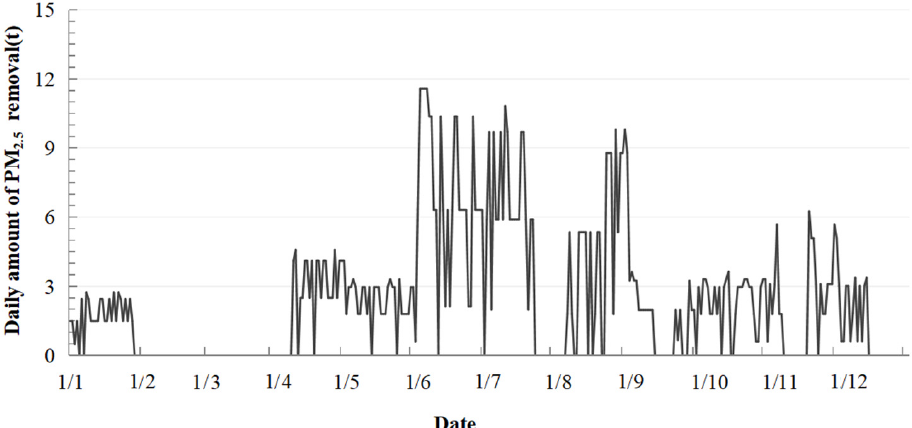
Figure 4. Daily amount of PM 2.5 removal by the urban forests in 2017.